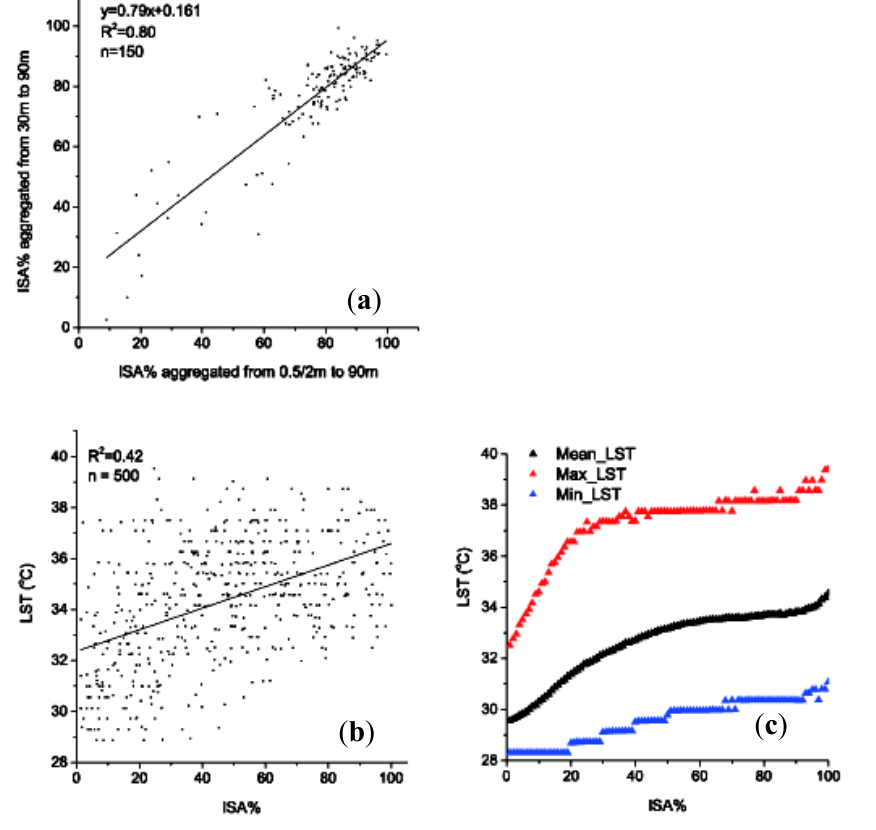
Figure 5. ( a ) Accuracy assessment of estimated ISA% on August 15, 2010; ( b ) Scatterplot of LST vs. ISA% on August 15, 2010; ( c ) Scatterplot of Mean LST vs. ISA% on 15 August